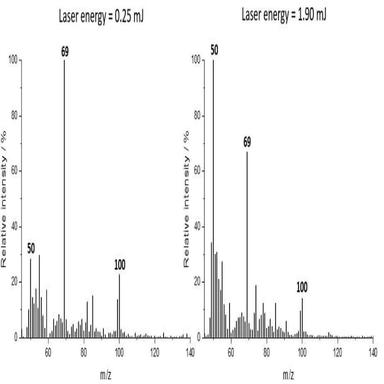
EI-MS spectra of ablated bulk PMMA with laser energy of 0.25 mJ (left) and 1.90 mJ (right).